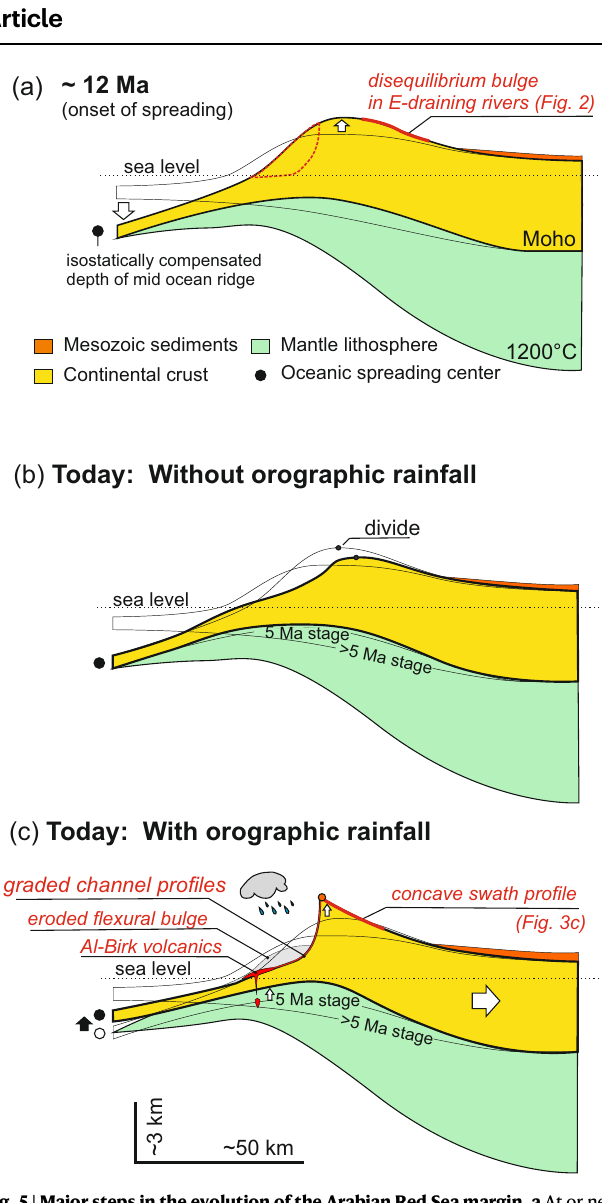
Fig. 5 | Majorstepsinthe evolutionofthe ArabianRed Seamargin. a Ator near the time of initial formation of oceanic lithosphere. Formation of oceanic litho- sphere in Red Sea downwarps margin and creates additional uplift by fl exural doming (future erosion dashed red). b , c Evolution since the initial formation of oceaniclithosphere. b Withoutorographicrainfall.Aminorescarpmentformsand erosion of uplifted area causes downwearing and backwards mirgrating escarp- ment with minor fl exural rebound in foreland, escarpment not exactly at divide (not realized or only realized in northern, dry part ofRed Sea depending on age of spreading there). c With orographic rainfall as for the southern Red Sea coast. Erosion causes additional uplift at escarpment edge, escarpment at divide, decompressional melting in foreland where fl exural bulge is eroded softens litho- sphere. Flexural lifting of the spreading center